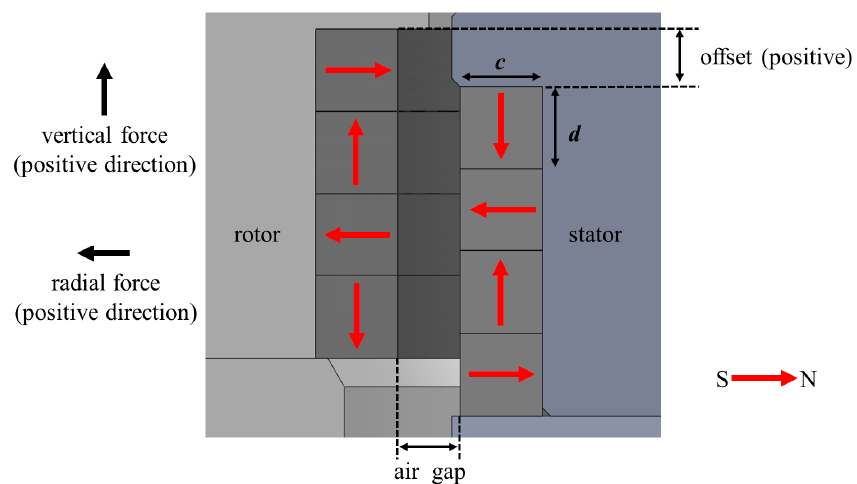
Figure 3. The schematic of the axial passive magnetic bearing (PMB).